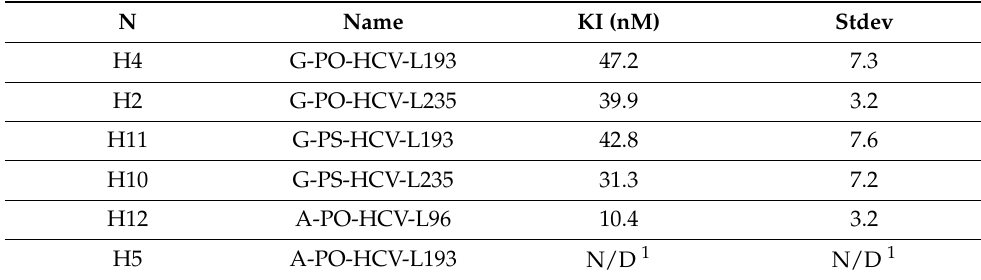
Table 3. Binding affinity to ASGPR using a mouse primary hepatocytes fluorescence-based assay